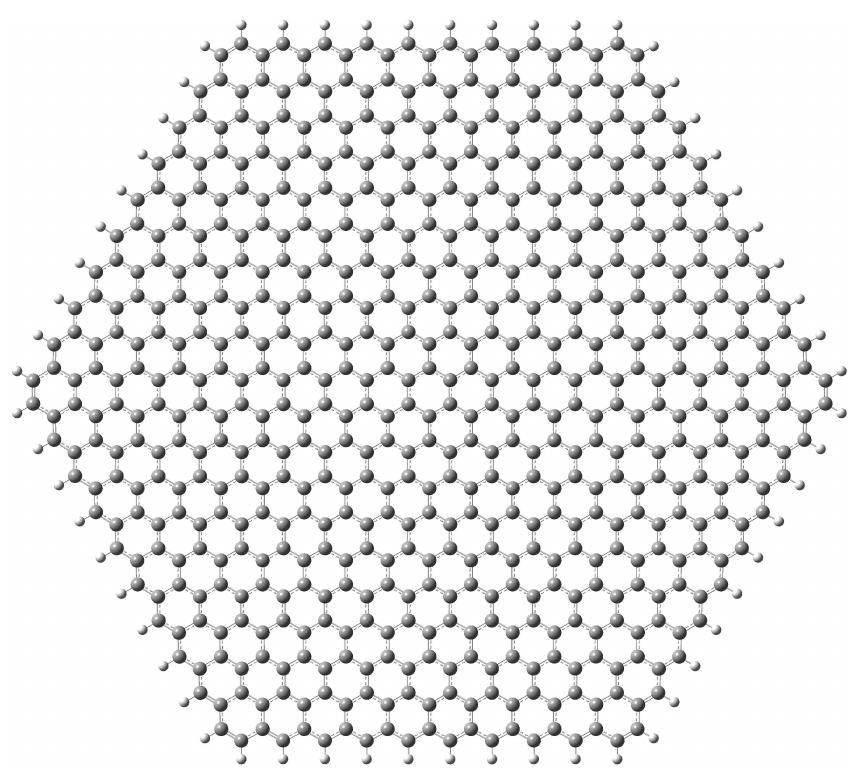
Figure 1. Graphene flake used in the calculations (image generated using GausView 6